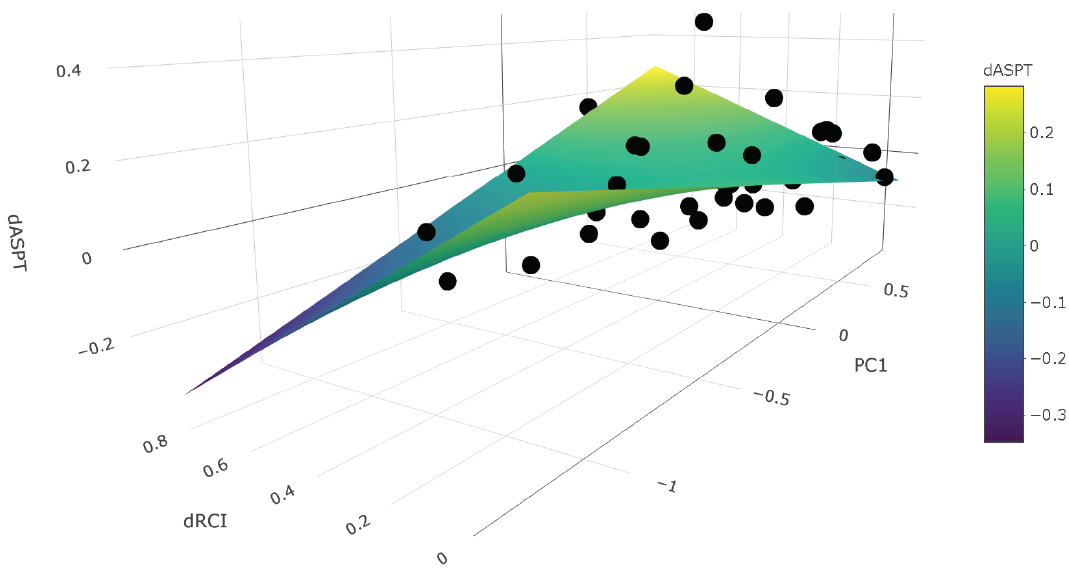
Figure 7. At paired sites across our four case-study basins, the size of the improvement in stream ecological status (ΔASPT) was positively associated with an interaction between the magnitude of the improvement in riparian condition (ΔRCI) and level of upstream human impacts (PC1). The result in this figure (see also Table 4) suggests that the riparian “magnitude of transition” effect on ΔASPT is dependent on the “environment context” (PC1). PC1 explains 37% variation in catchment-wide human impacts (i.e., indicating the level of upstream